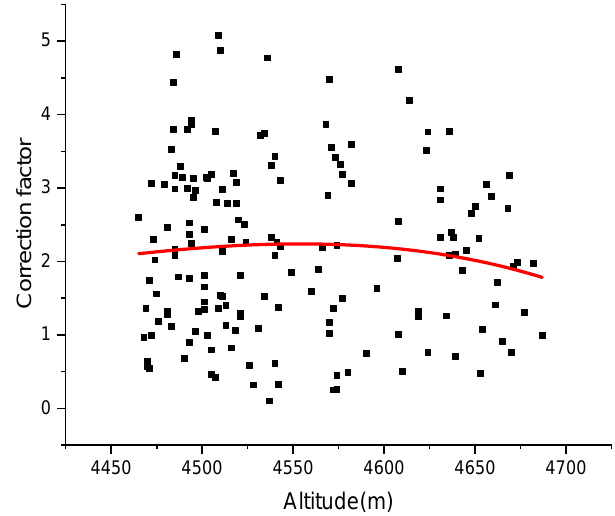
Figure 11. Variations in correction factor δ with altitude of segment 2.